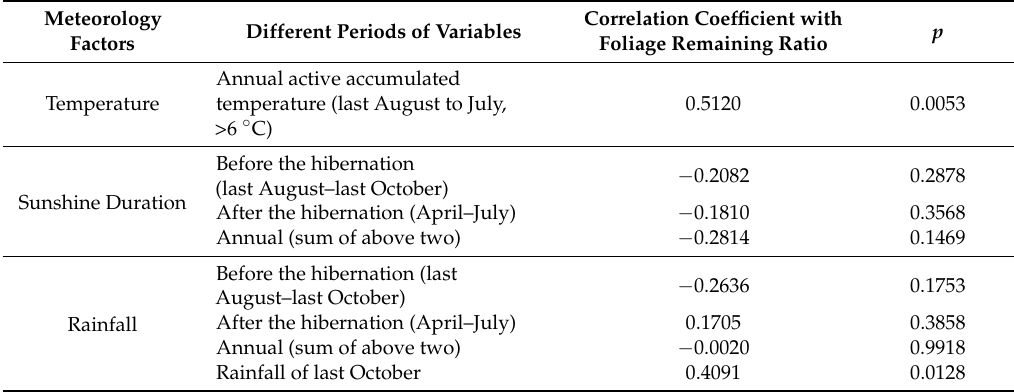
Table 2. Correlations between average foliage remaining ratio of 28 years and meteorology.